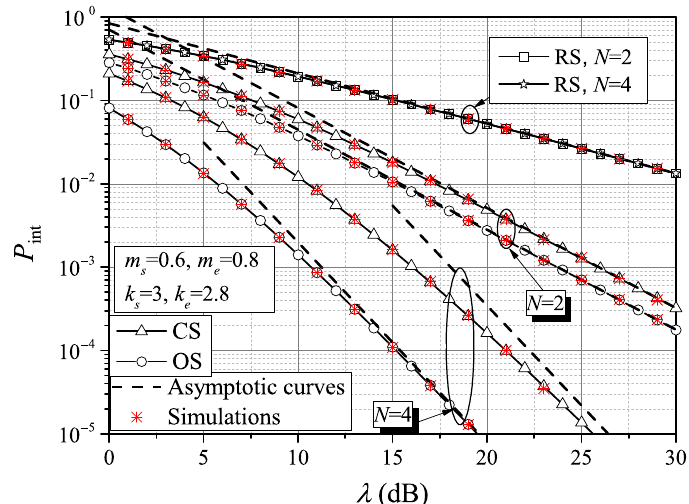
Figure 2. The intercept probability of the eavesdropped WSN vs. the average MER.